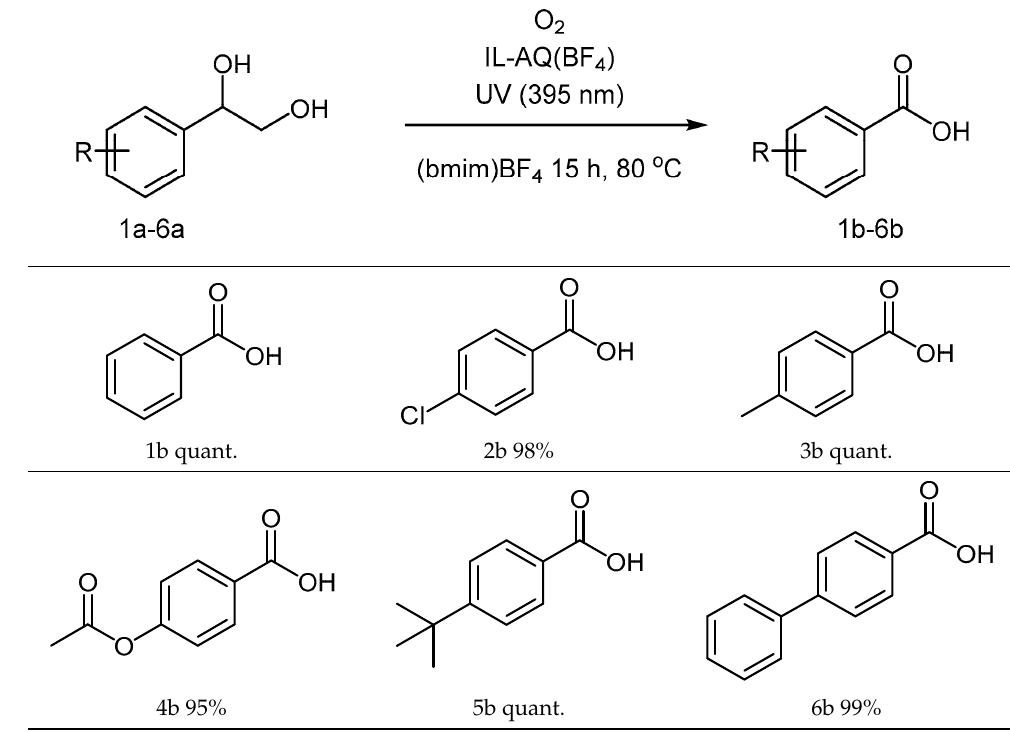
Table 2. Scope of the vicinal diols a . a Condition: substrate (0.3 mmol), IL-AQ(BF 4 ) (0.03 mmol),